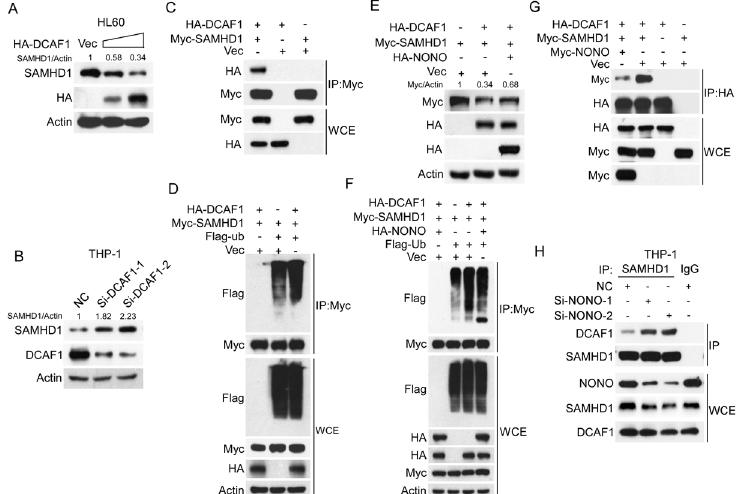
Fig. 4 NONO blocks the ubiquitination-mediated degradation of SAMHD1 by DCAF1. A , B Overexpression or silencing of DCAF1 decreased or increased SAMHD1 expression, respectively. A HL60 cells were transfected with increasing concentrations of HA-tagged DCAF1 24 h, and the levels of the indicated proteins were determined by western blotting. B THP-1 cells were transfected with DCAF1 siRNAs for 24 h, and the levels of the indicated proteins were then determined by western blotting. C DCAF1 interacts with SAMHD1. 293 T cells were transfected with HA-tagged DCAF1 and Myc-tagged SAMHD1 for 24 h. Co-IP was performed with anti-Myc agarose, and the interactions were examined by western blotting. D Overexpression of DCAF1 increased the ubiquitination level of SAMHD1. Myc-tagged SAMHD1 was cotransfected with HA- tagged DCAF1, Flag-ubiquitin or empty vector into 293 T cells for 24 h, and the ubiquitination level of SAMHD1 was determined using IP followed by western blotting. E NONO blocked DCAF1-mediated degradation of SAMHD1. Myc-tagged SAMHD1 and HA-tagged DCAF1 were cotransfected into 293 T cells with or without overexpression of HA-tagged NONO for 24 h. The levels of the indicated proteins were determined by western blotting. F Overexpression of NONO inhibited DCAF1-mediated ubiquitination of SAMHD1. Myc-tagged SAMHD1, HA- tagged DCAF1, and Flag-tagged ubiquitin were cotransfected into 293 T cells with or without overexpression of HA-tagged NONO for 24 h. The ubiquitination of SAMHD1 was evaluated by IP followed by western blotting. G NONO inhibits the interaction of DCAF1 and SAMHD1. Myc-tagged SAMHD1 and HA-tagged DCAF1 were cotransfected into 293 T cells with or without overexpression of Myc-tagged NONO for 24 h. Cells were subsequently subjected to co-IP followed by western blotting with the indicated antibodies. H Silencing of NONO increases the interaction of DCAF1 with SAMHD1. THP-1 cells silencing NONO for 48 h were lysed and were subsequently subjected to co-IP followed by western blotting with the indicated antibodies. For respective immunoblots, the protein levels were quanti fi ed by ImageJ software.